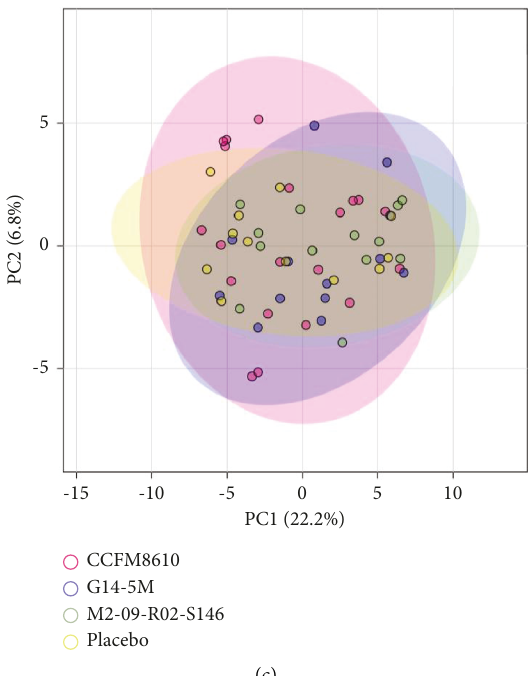
Figure 4: α - and β -diversity analysis of the gut microbiota at end-of-trial. (a) Observed species index; (b) Shannon index; (c) β -diversity, principal component analysis